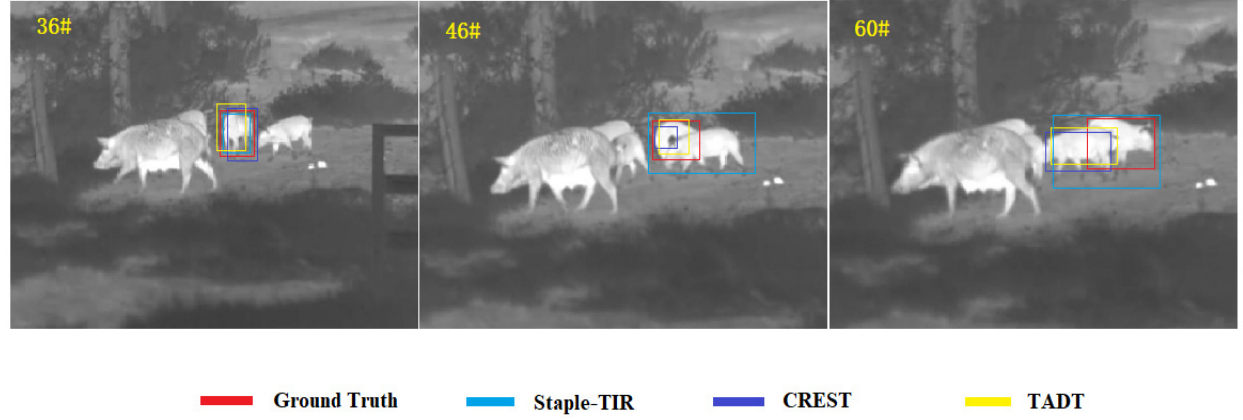
Figure 1. The performance of current methods in dealing with the challenge of interference from similar objects.